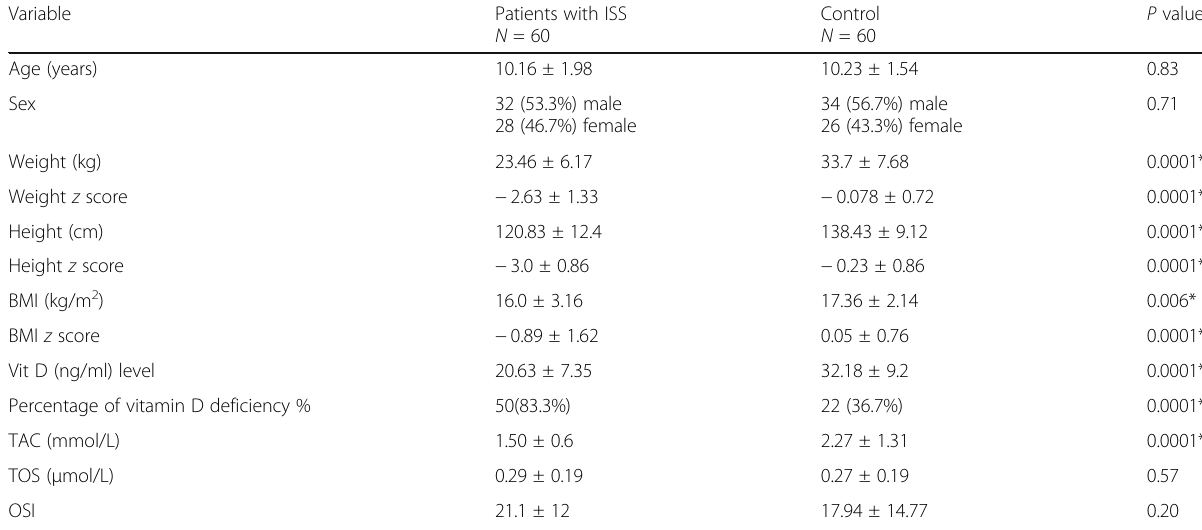
Table 1 Characteristics data of the studied groups